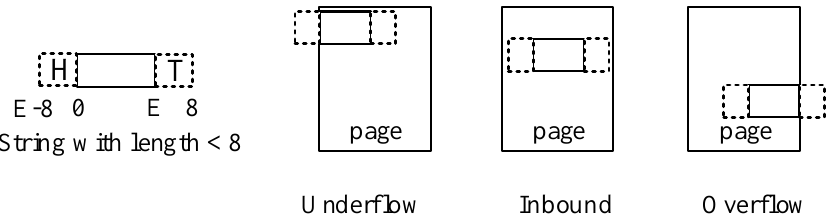
Figure 6. Three different cases of the memory layout of a string key with length shorter than eight